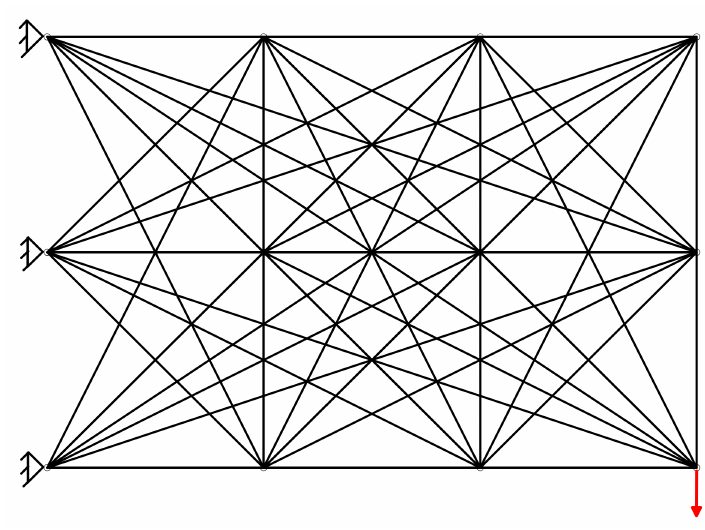
Figure 11. Ground structure of the 63-bar